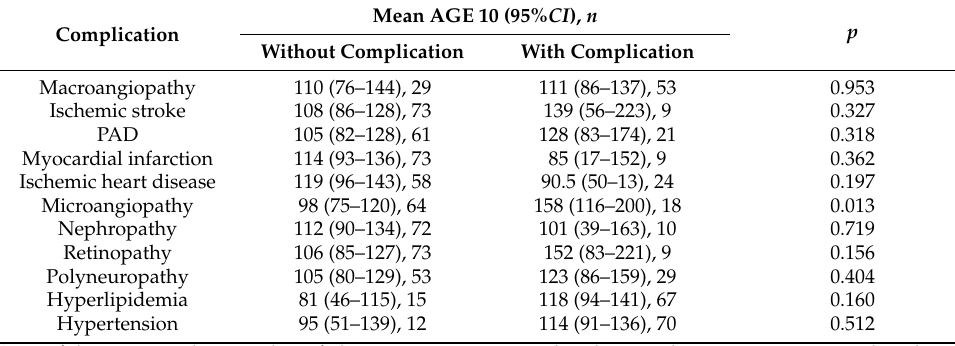
Table 2. AGE10 association with complications of